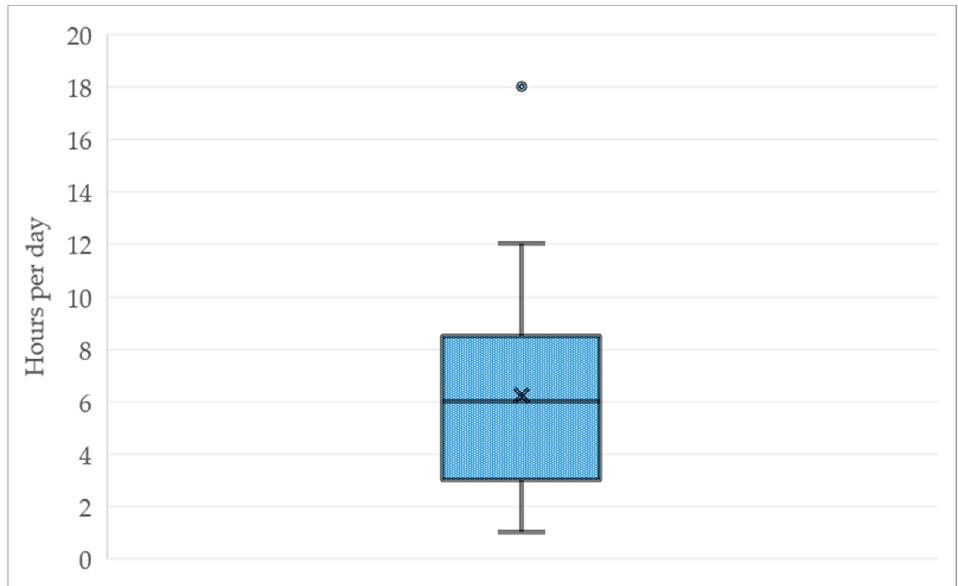
Figure 5. Hours per day with electricity access.